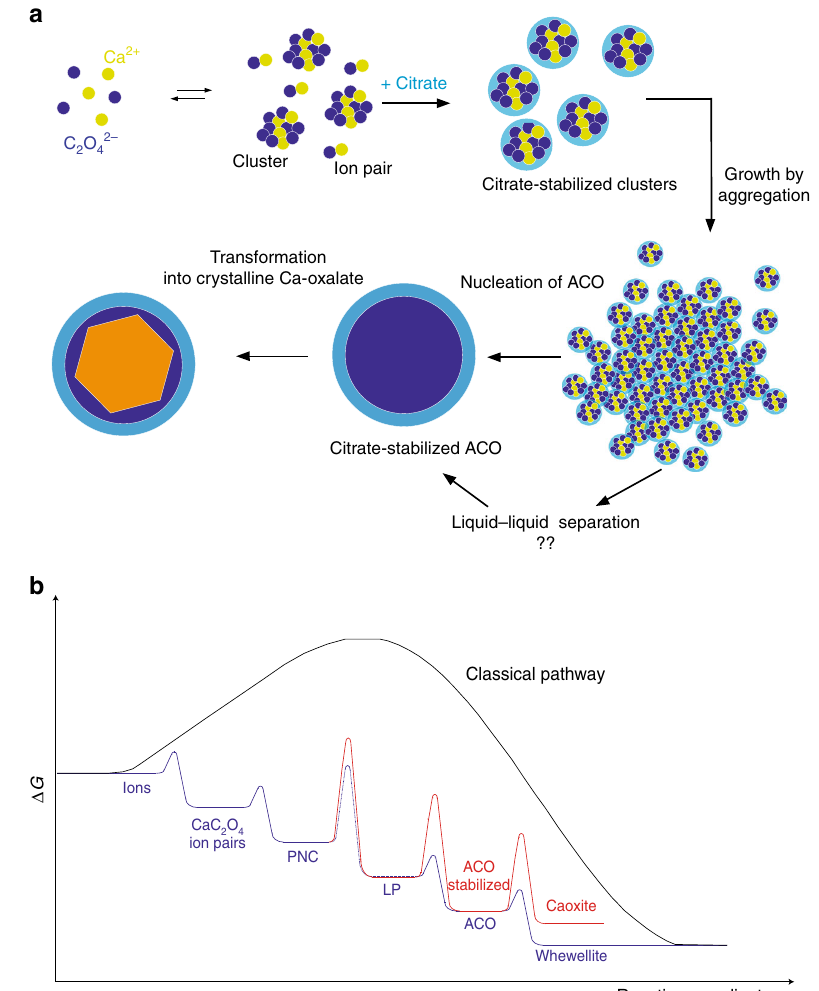
Fig. 10 Non-classical pathways during calcium oxalate precipitation in the presence of citrate. a Schematic drawing illustrating the sequence of stages during calcium oxalate formation in the presence of citrate. b An overview of the energetics of calcium oxalate crystallization pathways from supersaturated solutions under thermodynamic (classical pathway, black line ) and kinetic control (this study, blue line in the absence of citrate and red line in the presence of